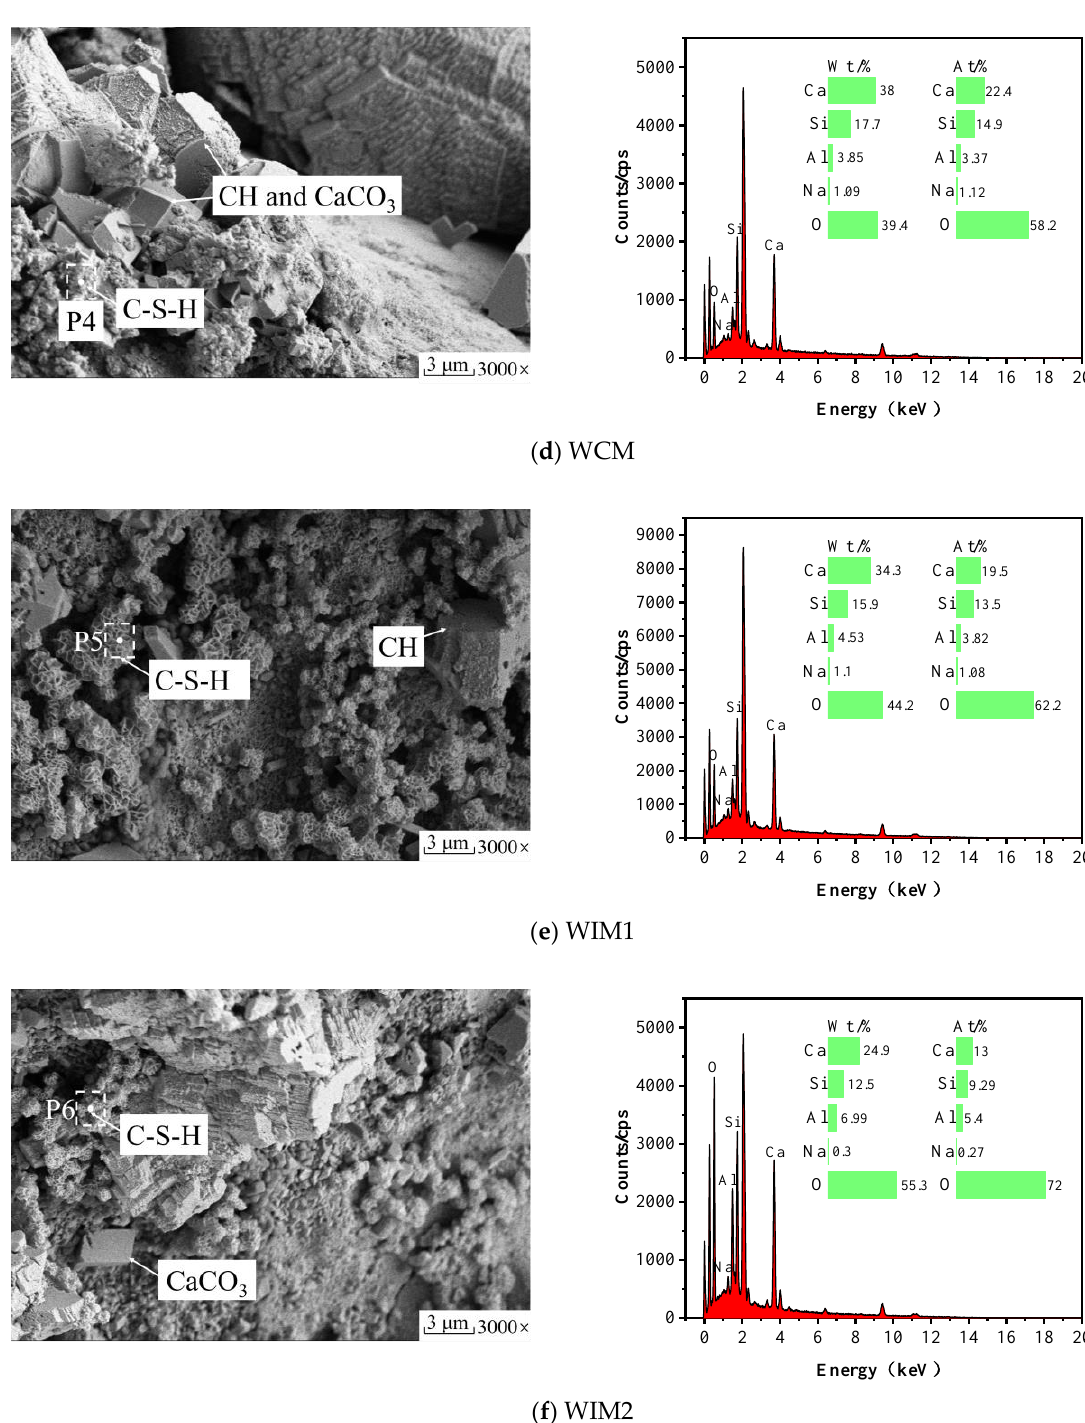
Figure 17. SEM-EDS results of different specimens: ( a ) SCM; ( b ) SIM1; ( c ) SIM2; ( d ) WCM; ( e ) WIM1; ( f) WIM2.